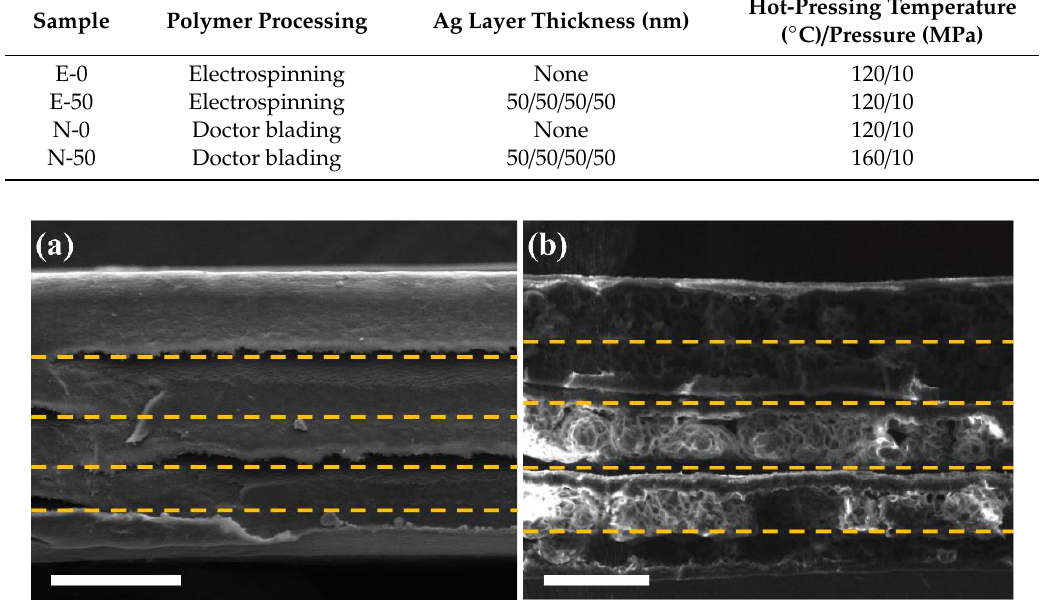
Figure 1. Cross-section view SEM images of the prepared composites including Ag layers such as ( a ) E-50 and ( b ) N-50. The yellow dashed lines indicate interfaces between the four Ag-deposited layers and the electrospun mat or the non-porous film. The multiple layers of N-50 were separated when they were cut for cross-sectional SEM imaging. The scale bars are 50 μ m in both ( a , b ).